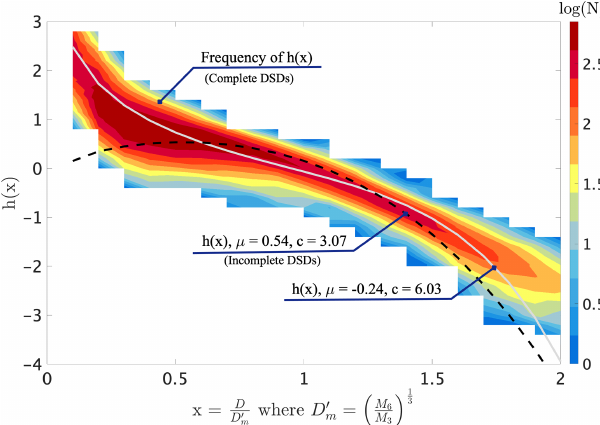
Figure 7. The frequency of occurrence plot of h(x) from Gree- ley, CO, with overlay of the fitted G-G ( µ = − 0 . 24, c = 6 . 03). The dashed black line is h(x) based on incomplete spectra using 2DVD data only. Note that the y axis is on a log axis, and therefore many zeros for large values of x are not shown but still affect the per-class median values to which the fits are